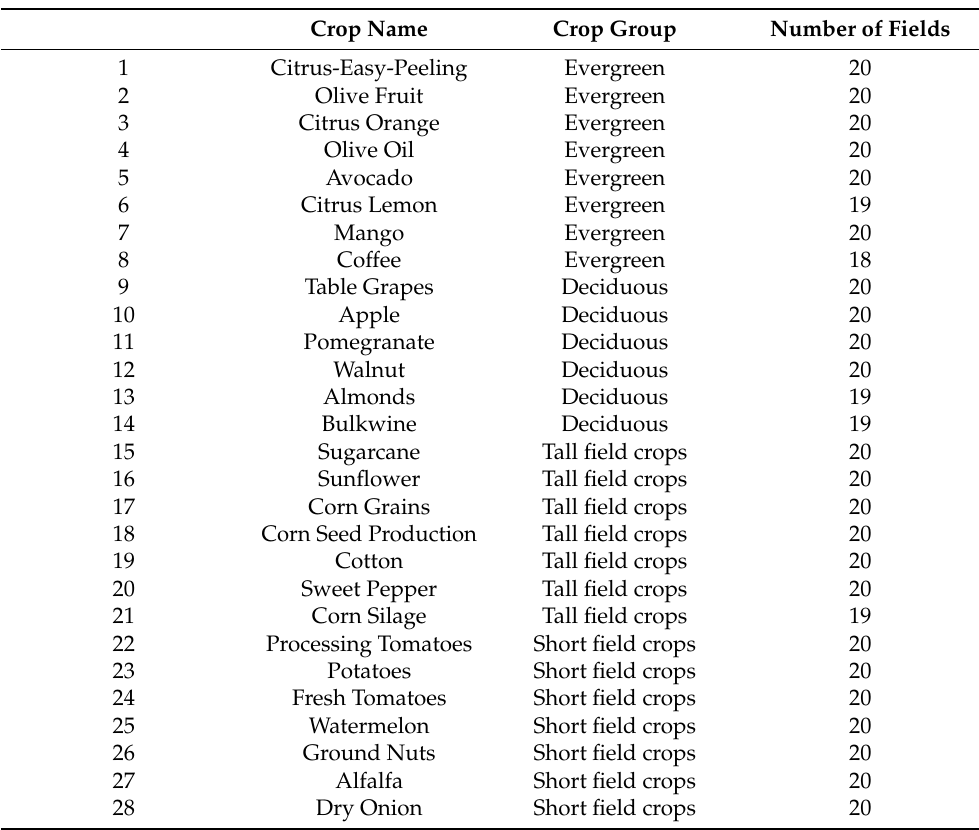
Table 1. The crops used in this study.